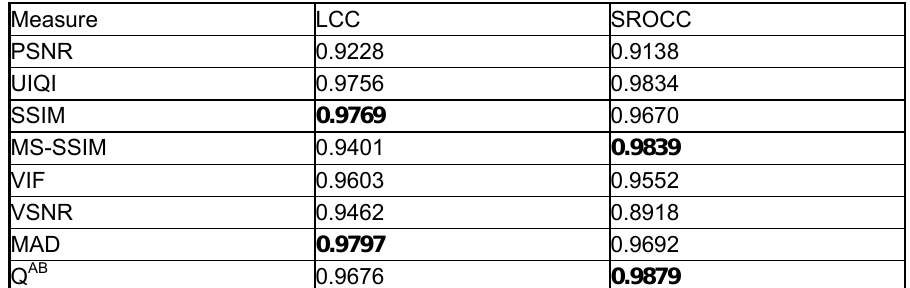
Table 4 – Comparison of objective quality assessment metrics performances after averaging subjective/objective scores on the JPEG XR Image